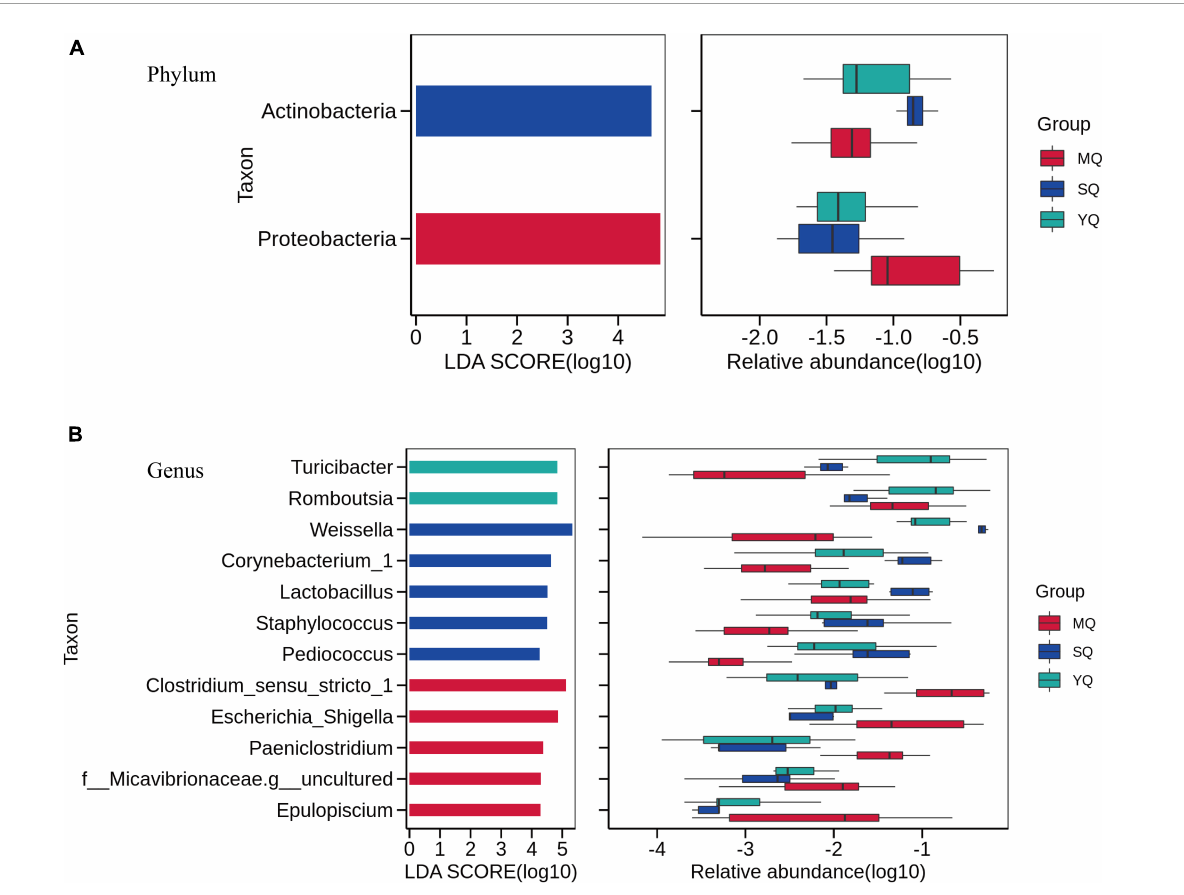
FIGURE4 Linear discriminant analysis effect size (LEfSe) analysis. The linear discriminant analysis identified significantly different taxon between MQ, SQ, and YQ at the phylum (A) and genus (B) levels with a threshold of LDA score ≥ 4.0 and p < 0.05. Left, logarithm score of LDA analysis for each taxon. Right, relative abundance of different taxon; MQ, raptors; SQ, waders; YQ, waterfowl; LDA, linear discriminant analysis; LEfSe, LDA Effect